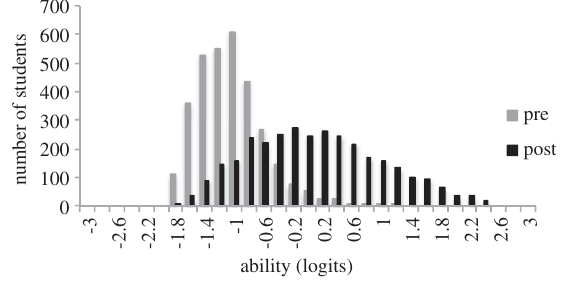
FIG. 6. The distribution of pre- and postinstruction abilities for the 2178 students in high-IAS classes with at least 25 students.